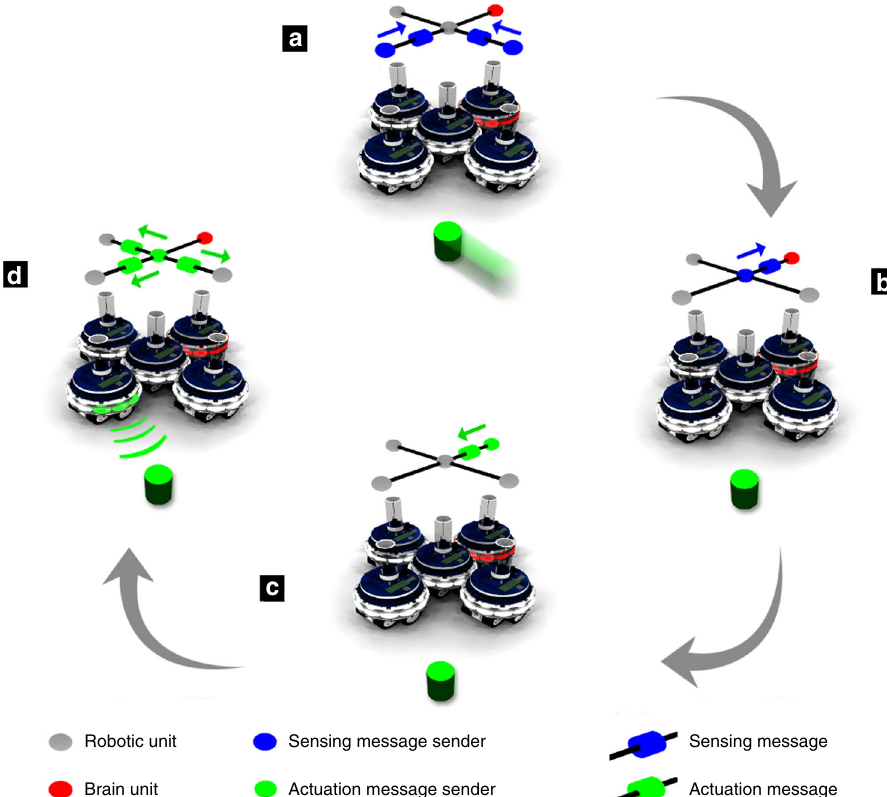
Fig. 4 Sensor and actuator information fl ow in an MNS robot. A 5-unit MNS robot detects and then responds to a stimulus. a: The stimulus moves within sensor range of two robotic units in the MNS robot. Both robotic units perform the computationally intensive visual image processing required to analyze their camera feeds. They pass an abstraction of this information (e.g., existence and coordinates of the stimulus) up to their parent robotic unit (i.e., the unit in the center of the robot) using a Wi-Fi connection. b: The parent robotic unit fuses the information coming from two of its child robotic units, to form a more accurate estimate of the stimulus ’ coordinates. The parent robotic unit then passes this single item of information up to its own parent robotic unit, which in this case is the brain unit. The brain unit decides what action to take, based on the data it has received — in this case, the decision is to point at and retreat from the stimulus. c: The brain unit issues high-level actuator commands. d: The high-level commands are translated into actuator instructions individually by each robotic